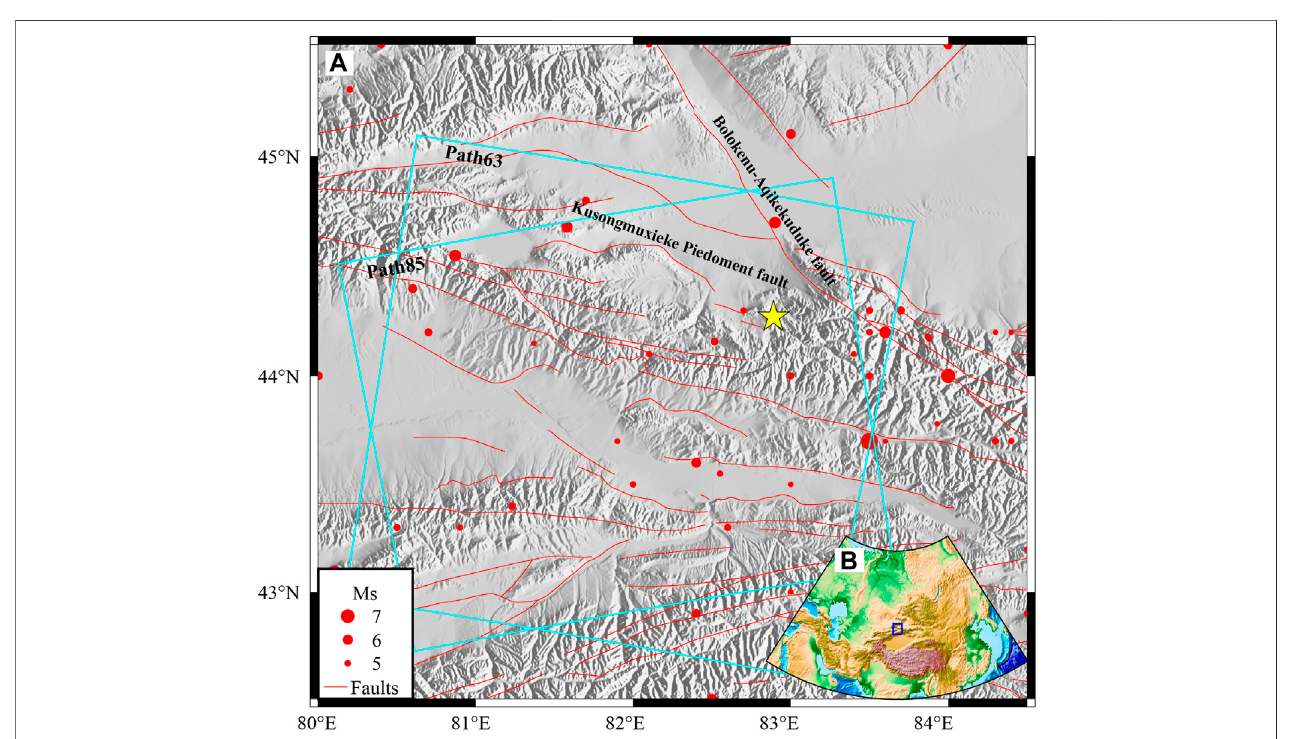
FIGURE1|(A) Faultmapofthestudyarea.JingheseismicityonAugust9,2017(redcircles)superimposedonatopographicreliefmap(Xuetal.,2016).Theyellow star is the location of the 2017 Jinghe event. The red lines denote the active faults. The blue frames are the coverage of the Sentinel-1 data. The red dots show historic events. The blue box in (B) inset indicates the area shown in (A) .